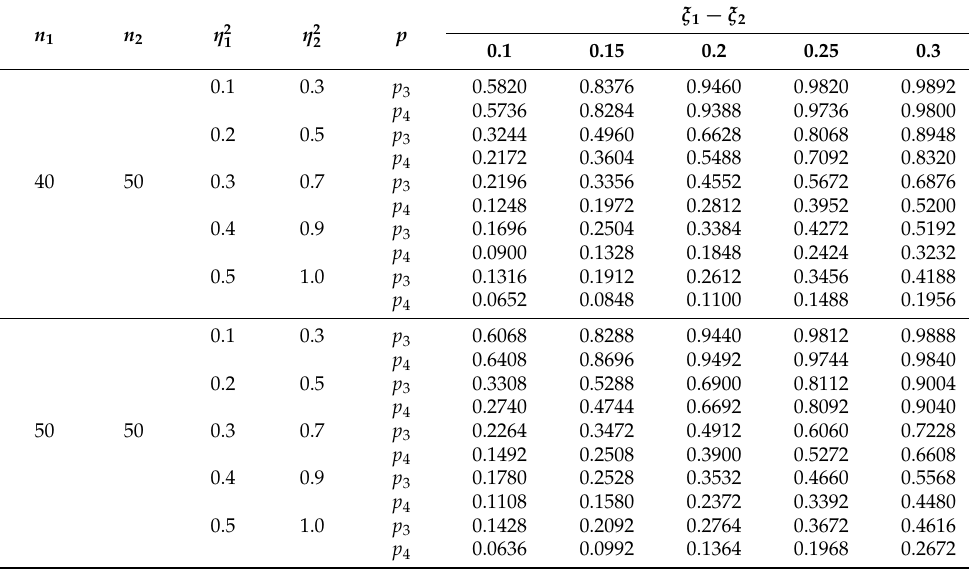
Table A5. Simulated powers of hypothesis testing problem (27) ( λ 1 = 4, λ 2 = 5 )